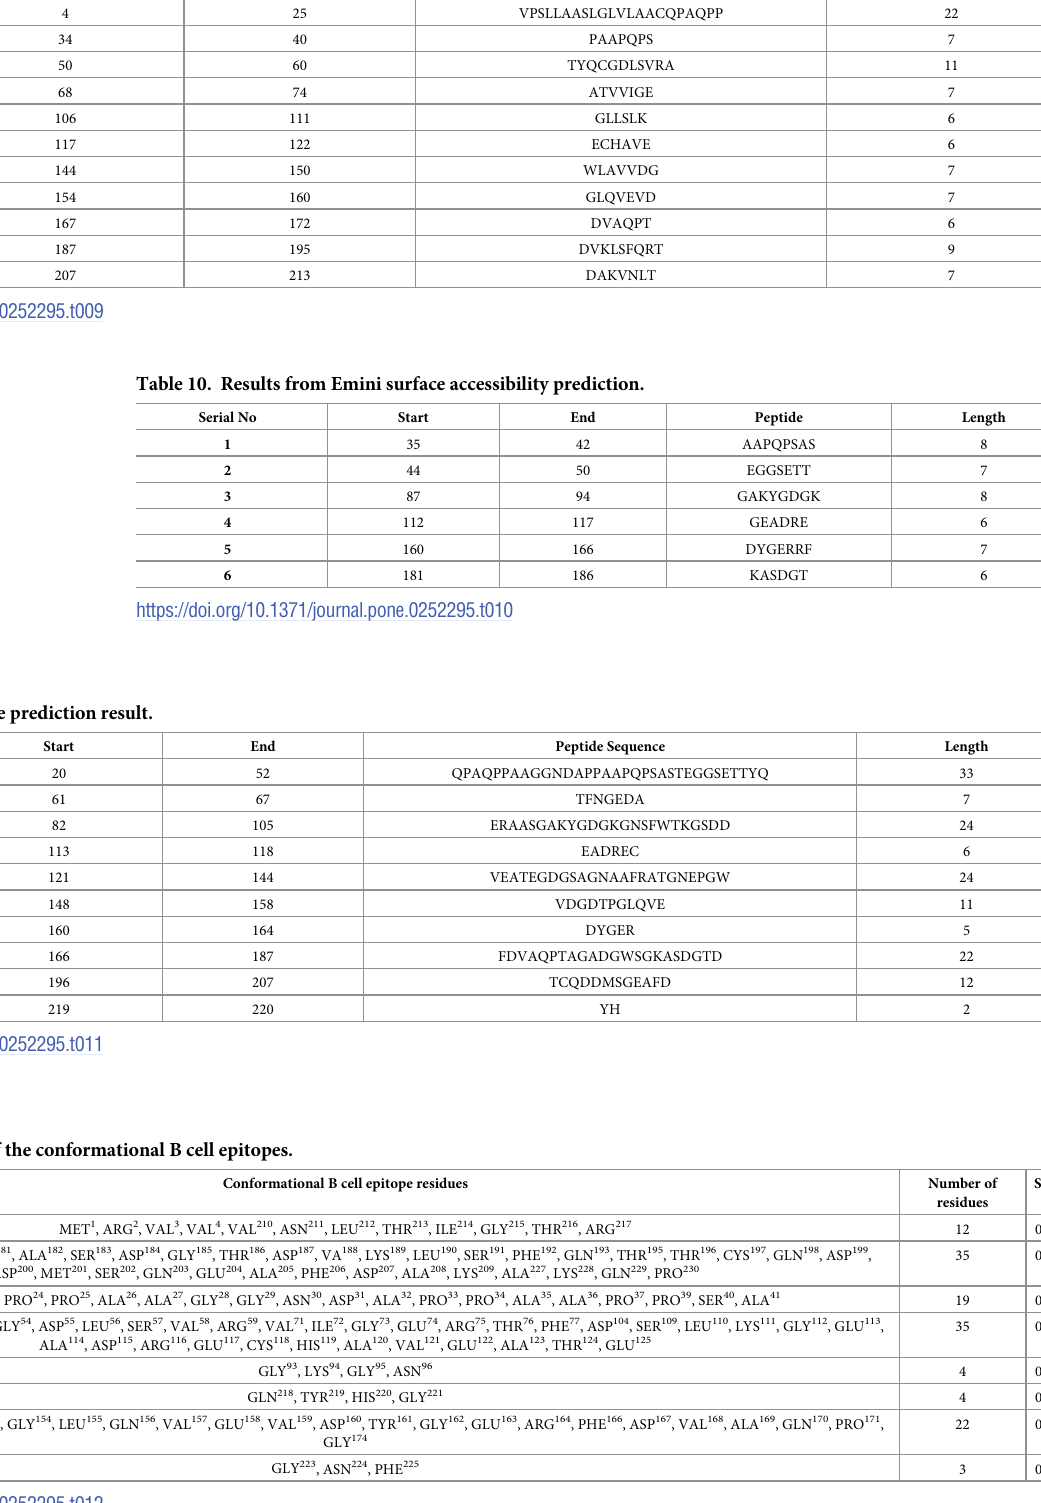
Table 9. Predicted epitope from Kolaskar and Tongaonkar antigenicity prediction tool. No.